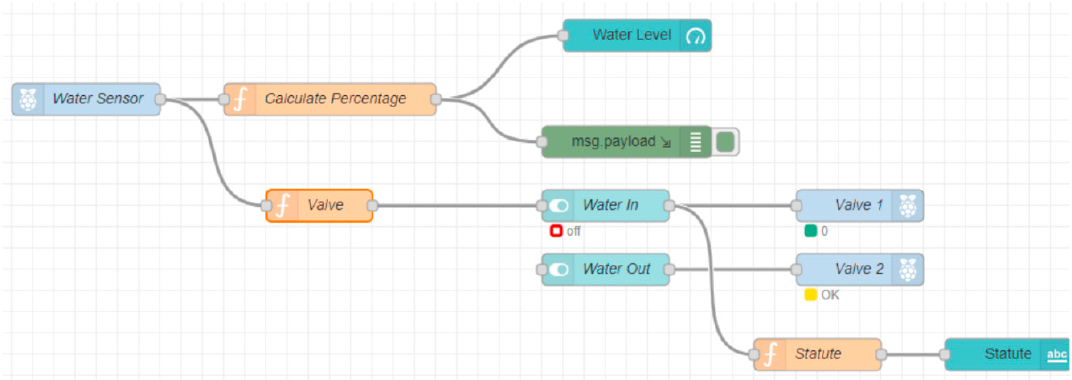
Figure 8. Water monitoring system process flow diagram.